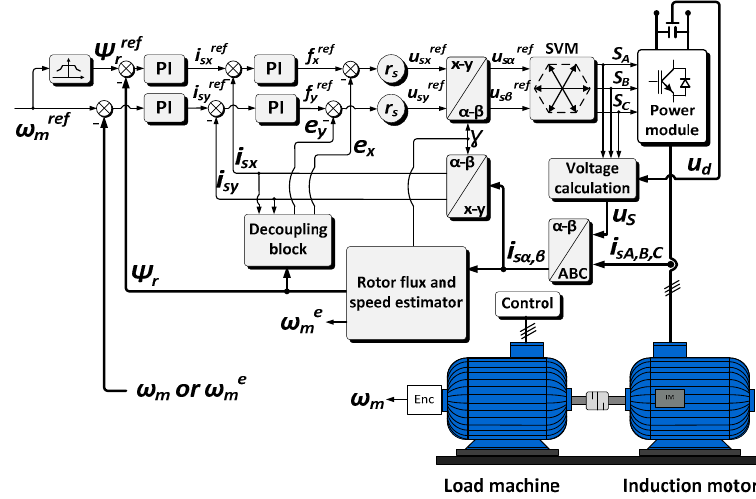
Figure 3. General scheme of the Direct Rotor Field Oriented Control (DRFOC).